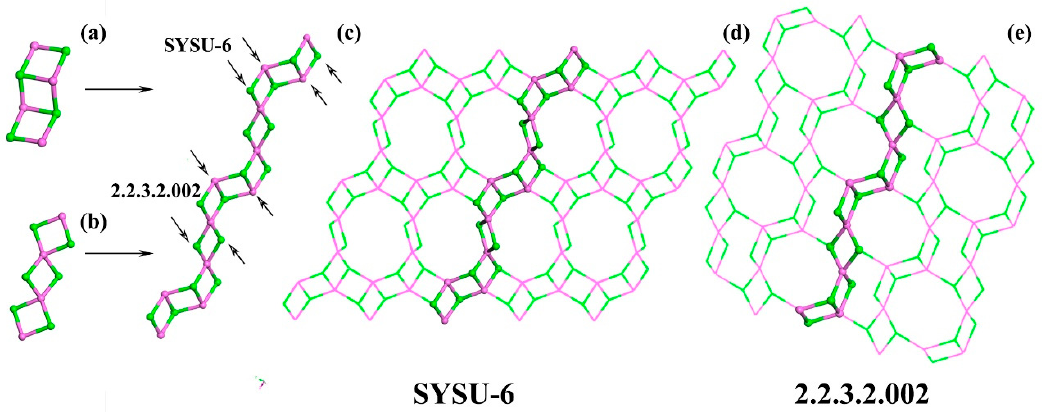
Figure 5. ( a ) Characteristic building unit “3 step ladder”; ( b ) Characteristic building unit “diamond telescopic hanger”; ( c ) Different connection way of the 4-ring infinite chain; ( d ) The layer of SYSU-6. ( e ) The layer of 2.2.3.2.002. Oxygen is omitted due to